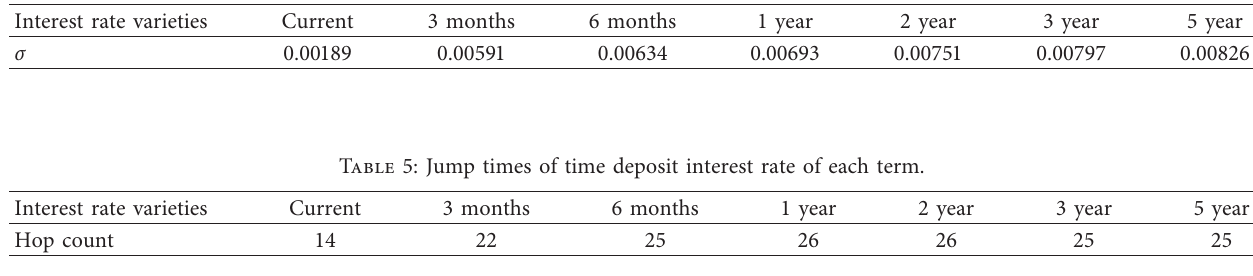
Figure 6: EViews regression results. Table 4: Time deposit interest rate volatility of each term.